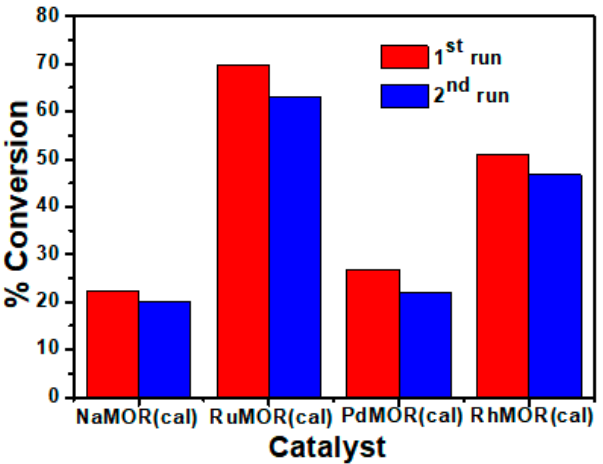
Figure 5. Catalytic performance of fresh (1 st run) and recycled (2 nd run) NaMOR(cal), RuMOR(cal), PdMOR(cal), and RhMOR(cal) materials for catalytic transfer hydrogenolysis (CTH) conversion of glycerol to 2-isopropoxy-propan-1-ol. The reaction was performed in a batch reactor at 140 °C for 72 h under an inert atmosphere, and at 0.5 MPa initial N 2 pressure (the autogenous pressure was 1.4 MPa during the reaction). RuMOR(cal) catalyst was found to be most efficient for conversion, which is attributed to the strong interaction between Ru and MOR, as evident from the XPS data (indicated by the binding energy peak of chemisorbed Ru-O at 529.3 eV).